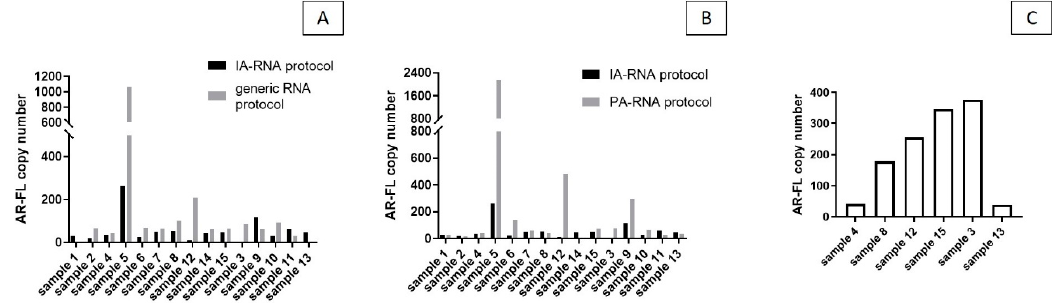
Figure 3. ( A ) AR-FL copies / mL identified with IA-RNA protocol vs. generic protocol, ( B ) with IA-RNA protocol vs. PA-RNA protocol and ( C ) in whole plasma in a subset of samples.